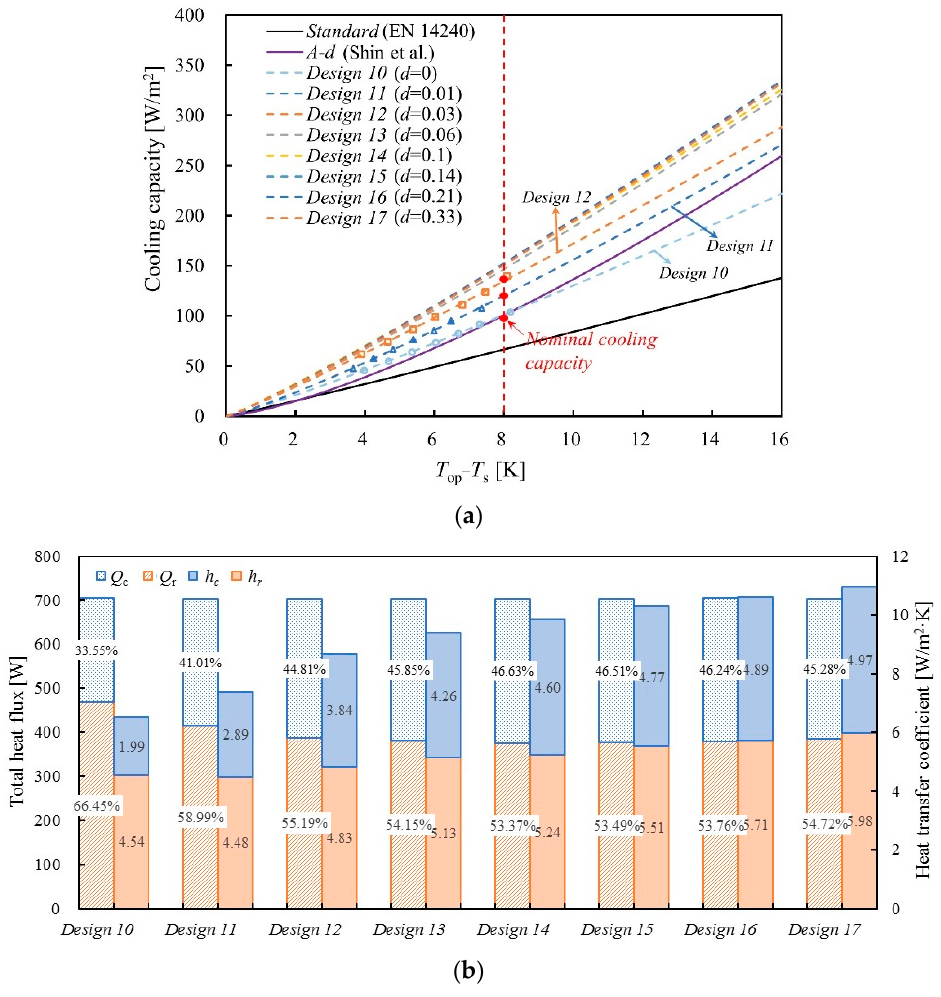
Figure 9. Comparison of different void distances ( a ), cooling capacity curves [27,32] ( b ), and thermal performances under a cooling load of 1405.02 W.